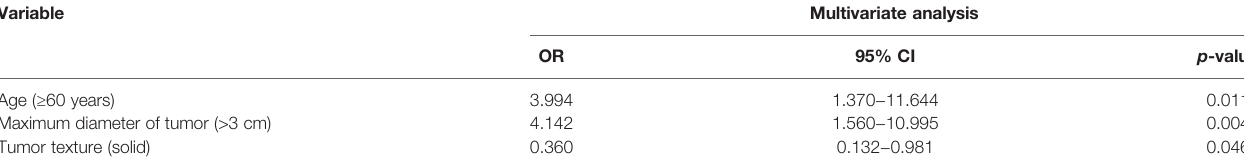
TABLE 5 | Multivariate logistic regression for extent of tumor adhesion.